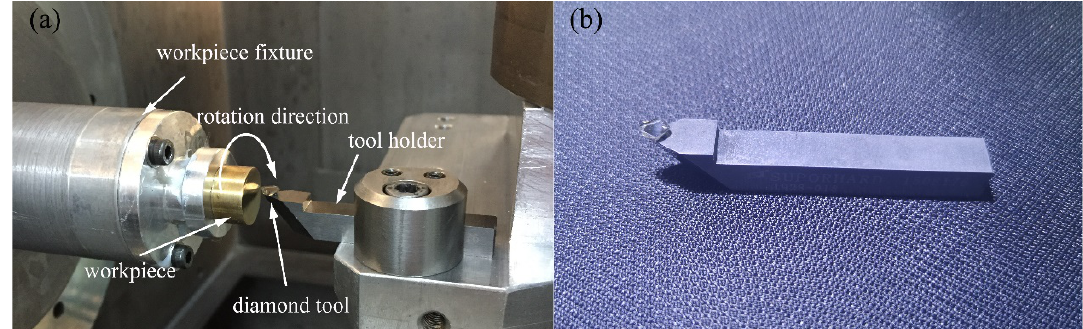
Figure 10. ( a ) The experimental setup and ( b ) the diamond tool .